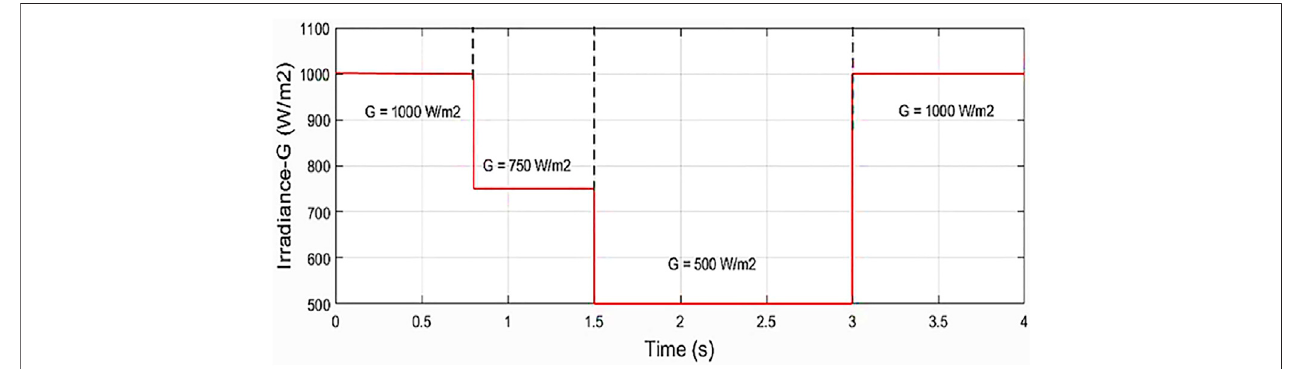
FIGURE 7 | Irradiance pattern for